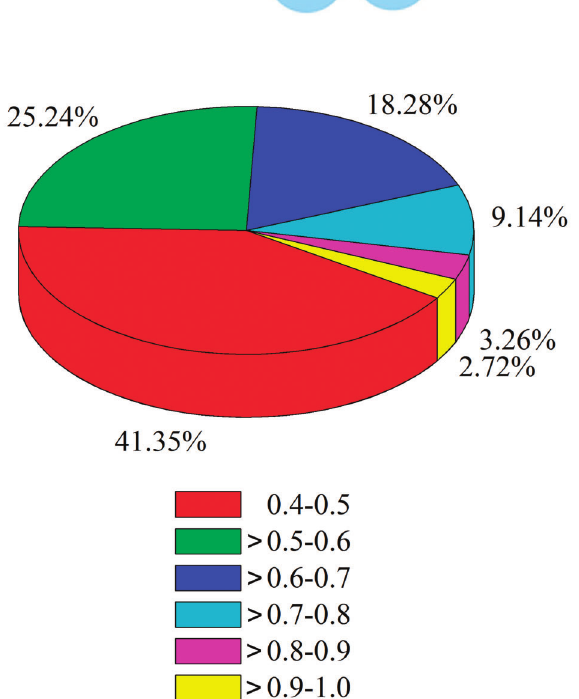
Figure 3. Pie chart showing the weight distribution of interactions in the differential co-expression network. The weight values were classi fi ed into the following groups: 4 0.9 – 1.0, 4 0.8 – 0.9, 4 0.7